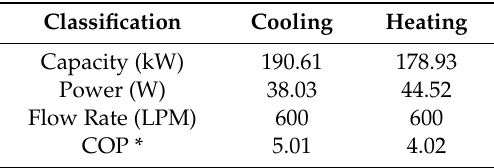
Table 1. Summary of heat pump.